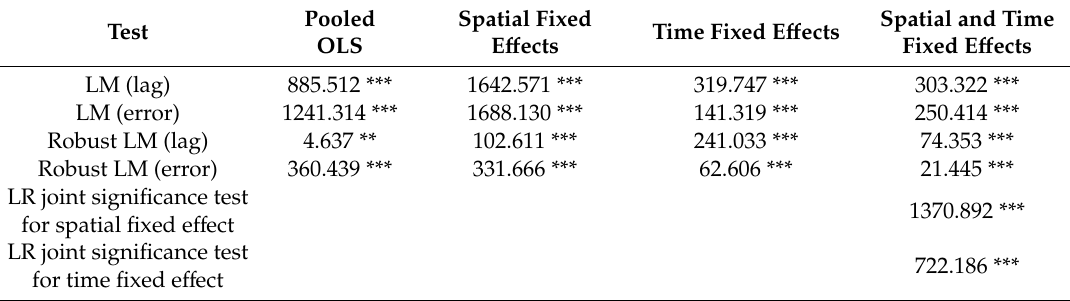
Table 4. Results of spatial diagnostic tests for non-spatial panel